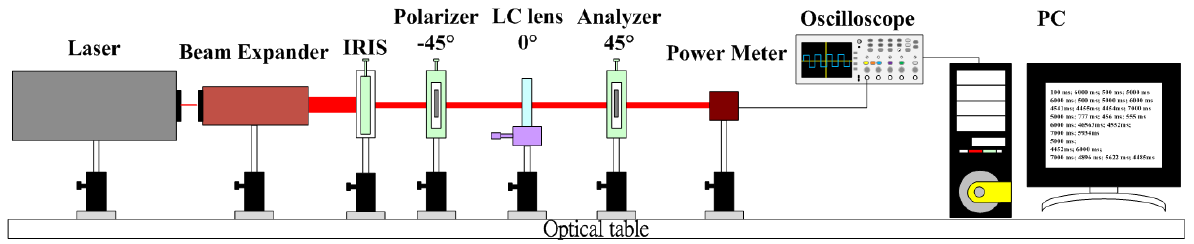
Figure 9. The experiment system with a power meter.